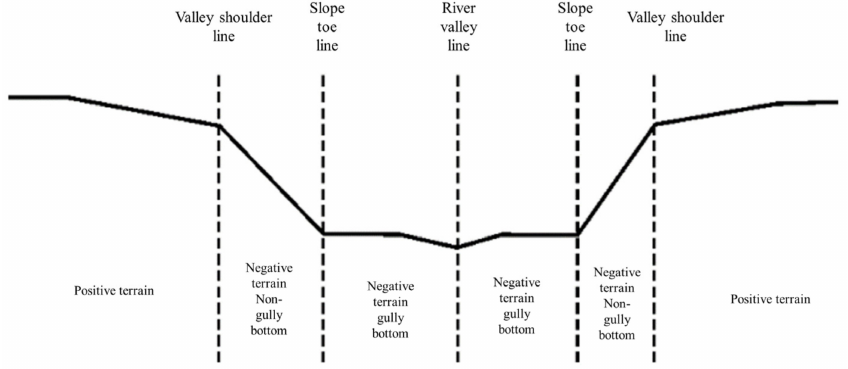
Figure 7. The diagram of the valley shoulder line and the slope toe line